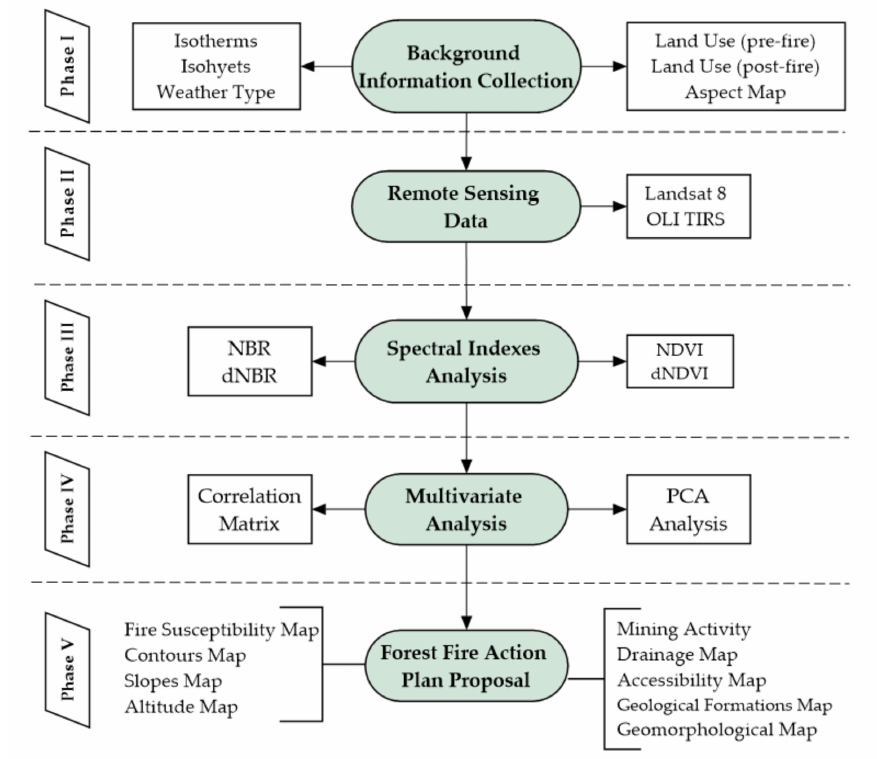
Figure 2. Methodological